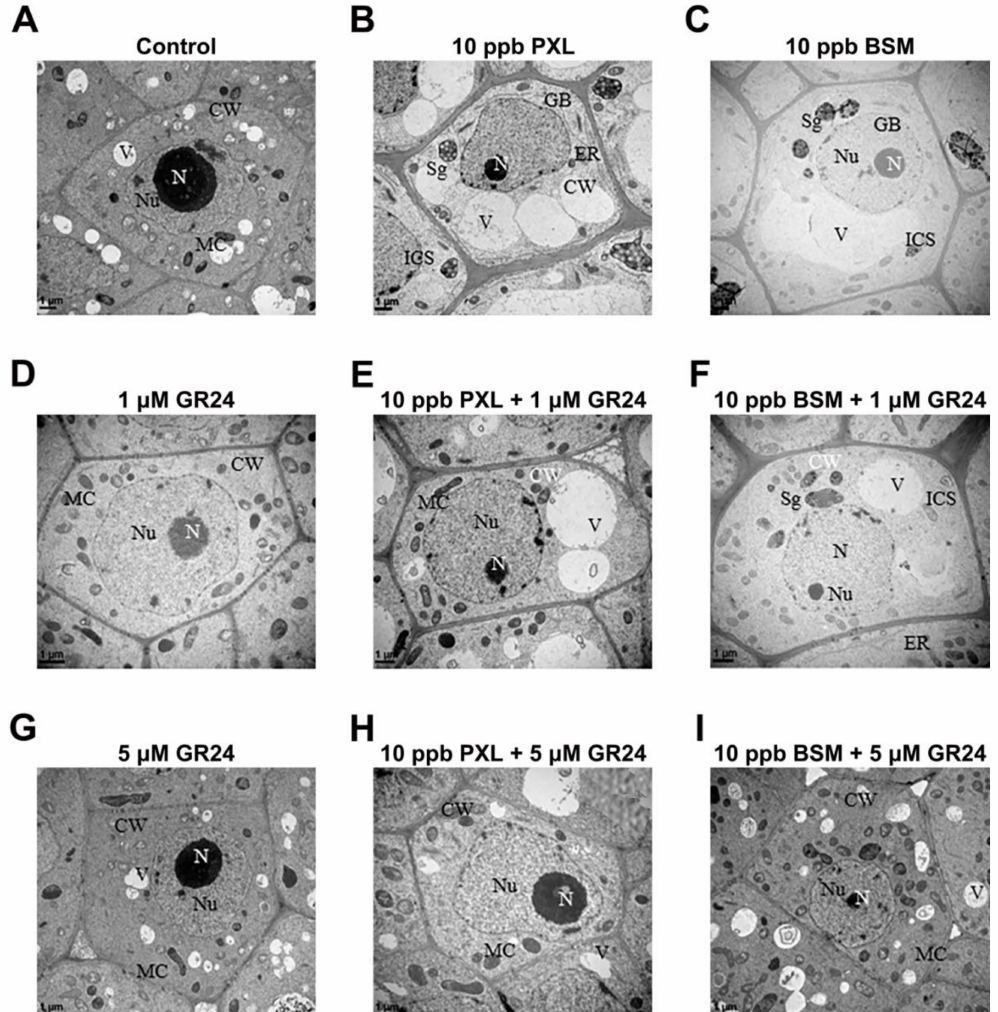
Figure 4. Effect of SL on the ultrastructure of root tips under herbicide treatments after three days. ( A ) Control, ( B ) PXL, ( C ) BSM, ( D ) 1 µ M GR24, ( E ) PXL + 1 µ M GR24, ( F ) BSM + 1 µ M GR24, ( G ) 5 µ M GR24, ( H ) PXL + 5 µ M GR24, and ( I ) BSM + 5 µ M GR24. CW (cell wall), V (vacuole), MC (mitochondria), N (nucleus), Nu (nucleolus), ICS (intercellular spaces), Sg (starch granules), GB (golgi bodies), and ER (endoplasmic